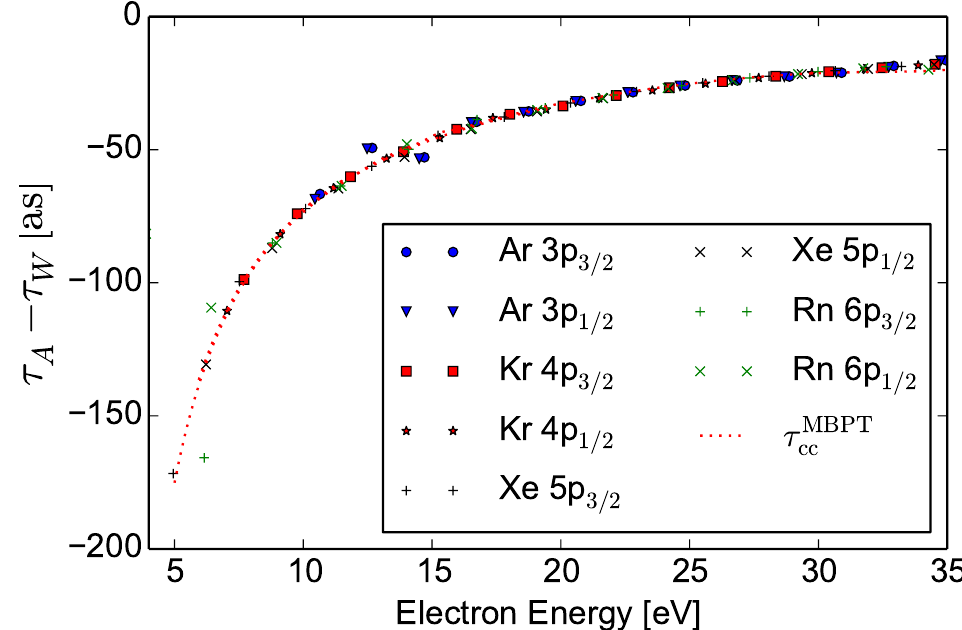
Figure 5. The difference between the atomic delay and the Wigner delay for the two outermost orbitals in Ar, Kr, Xe, and Rn calculated in length gauge and for for electrons emitted along the polarization axis. The red dotted line shows the non-relativistic result calculated for Ne 2 p , i.e., the numerically obtained continuum–continuum delay discussed in the